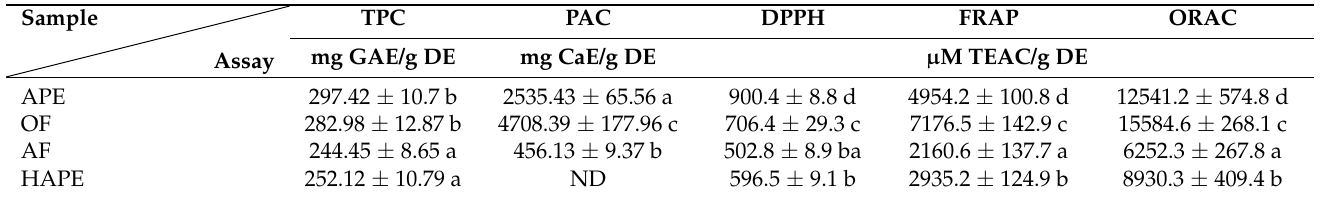
Table 2. Phytochemical characteristics and antioxidant activity of avocado peel